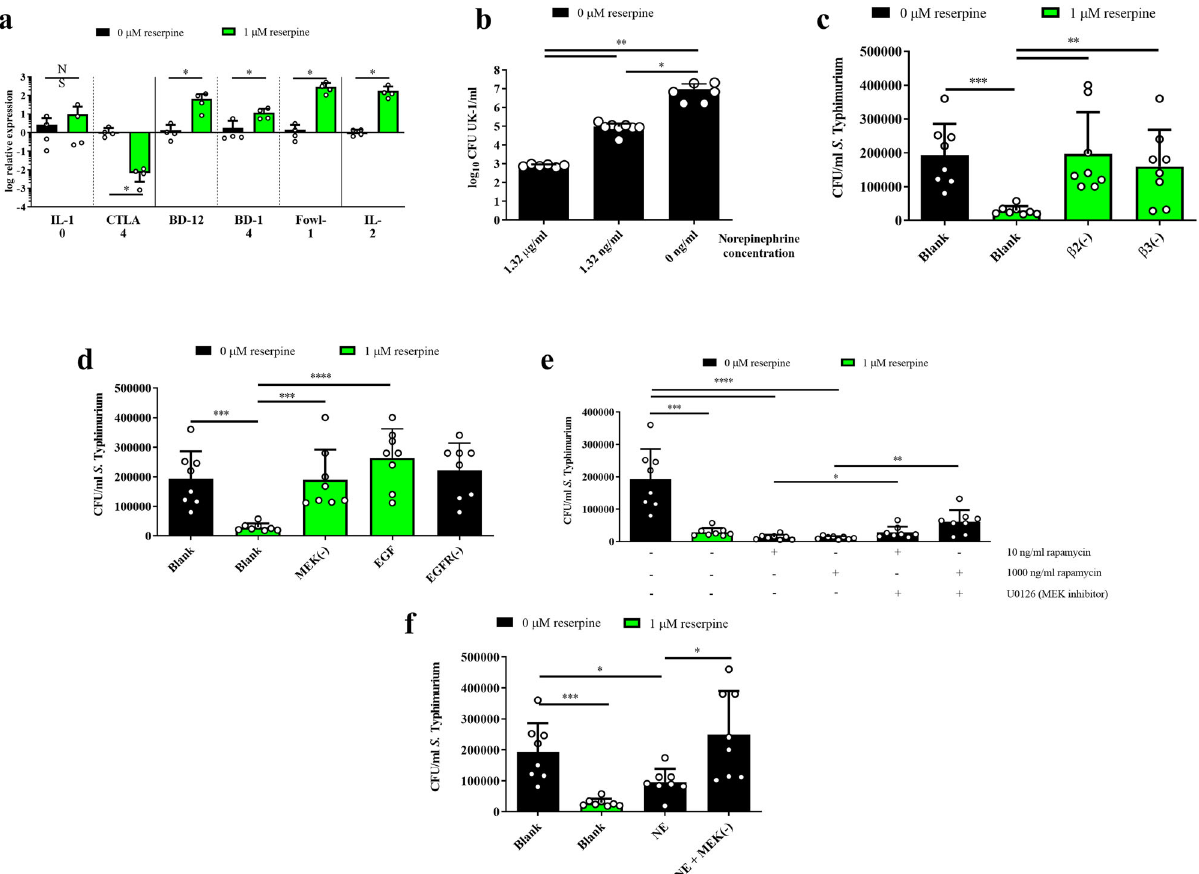
Fig. 4 Reserpine treatment increased antimicrobial peptide (AMP) gene expression, and reserpine-induced antibacterial responses were dependent on mTOR, EGFR, and MEK1/2 signaling. AMP and IL-2 gene expression was increased by reserpine treatment while CTLA-4 gene expression was decreased ( a ). Norepinephrine treatment alone increased anti- Salmonella responses in explants ( b ), and the effect of reserpine was blocked using beta- adrenergic receptor inhibitors ICI-118551 ( β 2 ) or L-748337 ( β 3 ) ( c ). Reserpine-induced antibacterial activities were inhibited by MEK1/2 kinase inactivation and EGF treatment ( d ), and rapamycin-induced bactericidal responses are partially dependent on MEK1/2 signaling ( e ). Finally, norepinephrine-induced bactericidal responses are dependent on MEK1/2 signaling ( f ). Signi fi cant differences indicated by asterisks: * P < 0.05; ** P < 0.01; *** P < 0.001; **** P < 0.0001. Error bars indicate the standard deviation above and below the